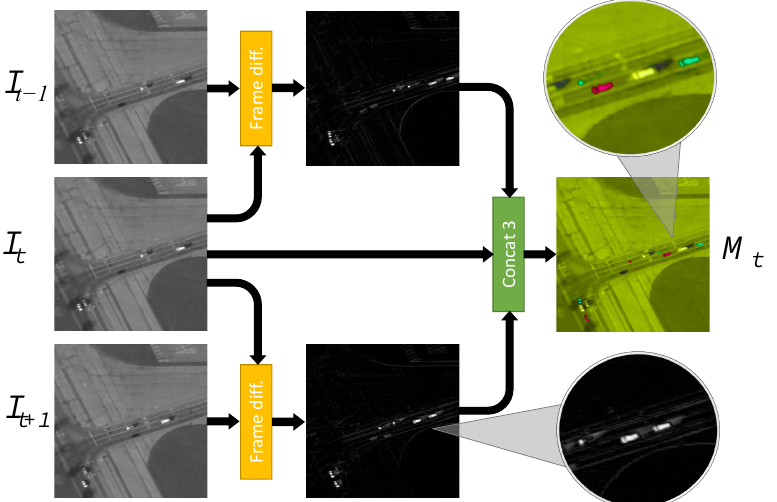
Figure 4. Computation of motion-augmented image M . For visualization purposes, after the concatenation, each of the three channels is displayed as a single color channel like in RGB images. Here, with respect to RGB, for visualization purposes the hue of the whole image has been modified. In the zoomed area of the final M image we can see that a moving car appears as 3 cars, corresponding to time instants t − 1, t and t +